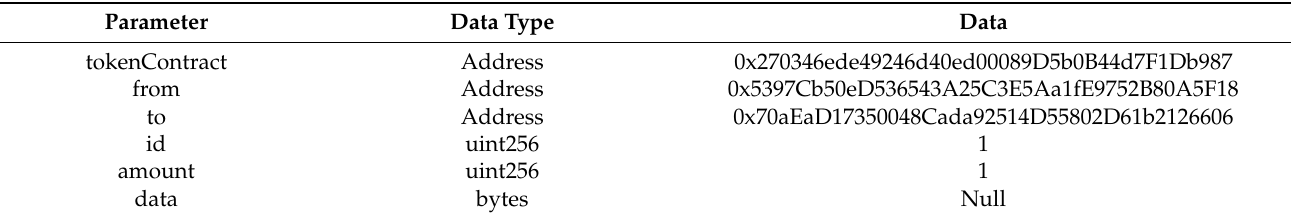
Table 7. Transaction data used in the second scenario.